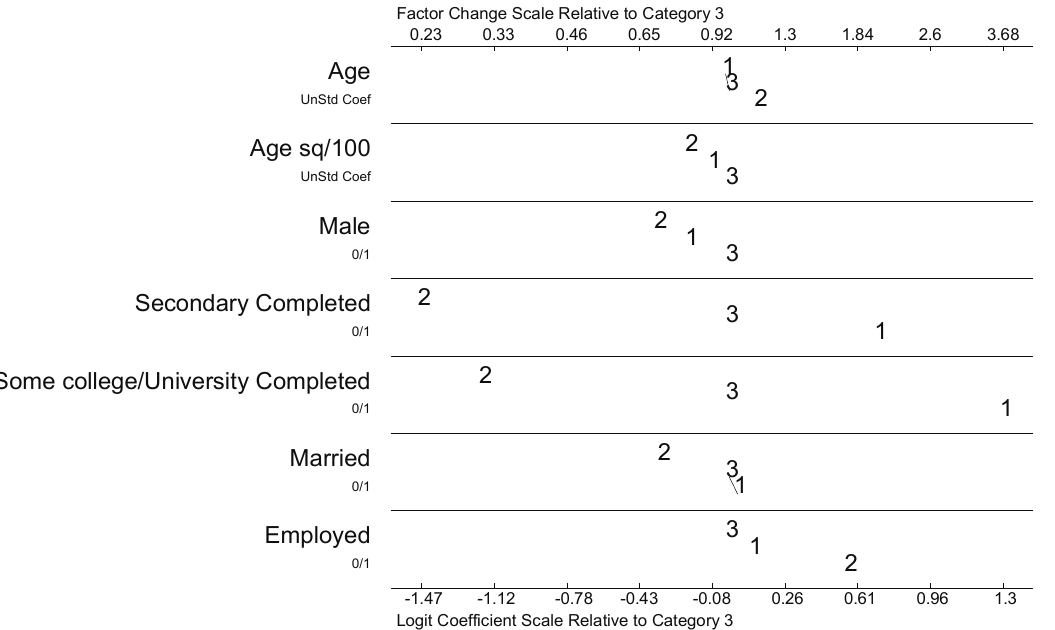
Factor Change Scale Relative to Category